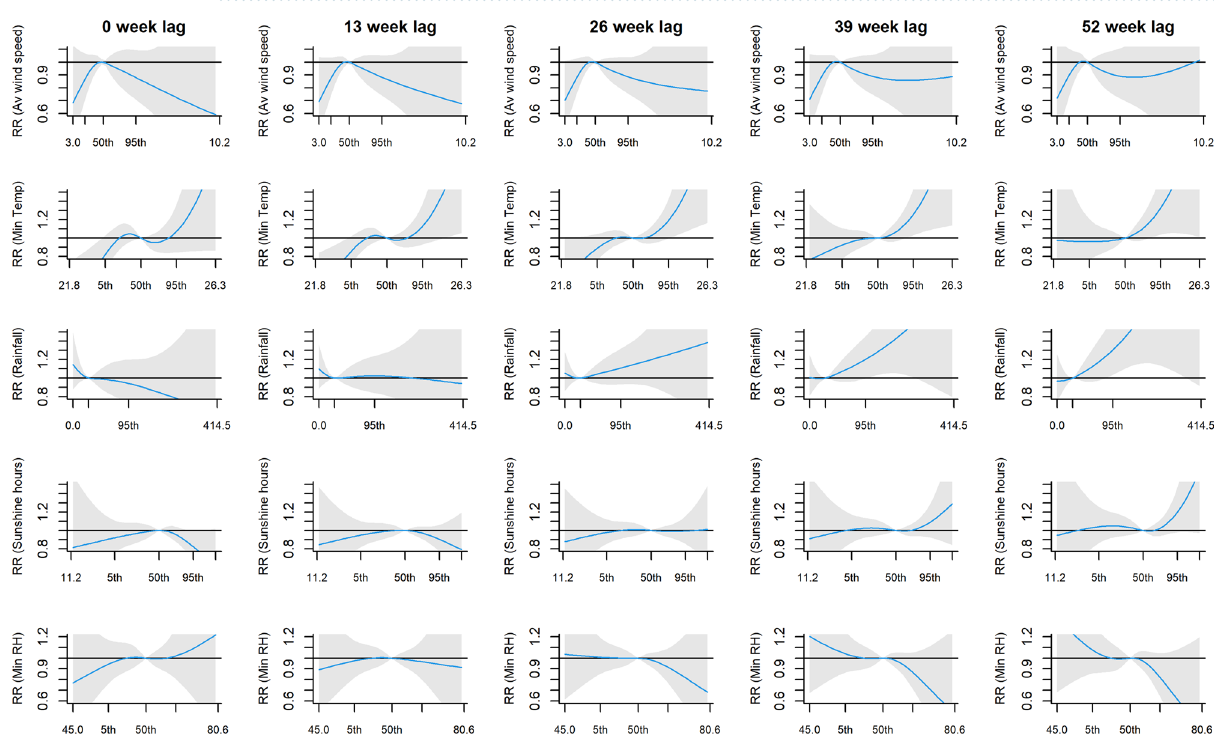
Figure 4. The lagged effects on the relative risk (RR) of PTB incidence from final multivariate model, of (from top to bottom) average wind speed, minimum temperature, total rainfall, total sunshine hours and minimum relative humidity, at lags 0, 13, 26, 39 and 52 weeks. There are 5 x-axis label ticks for each plot, corresponding to the minimum, 5th percentile, 50th percentile, 95th percentile and maximum. The areas shaded in grey correspond to the 95% Confidence Interval.